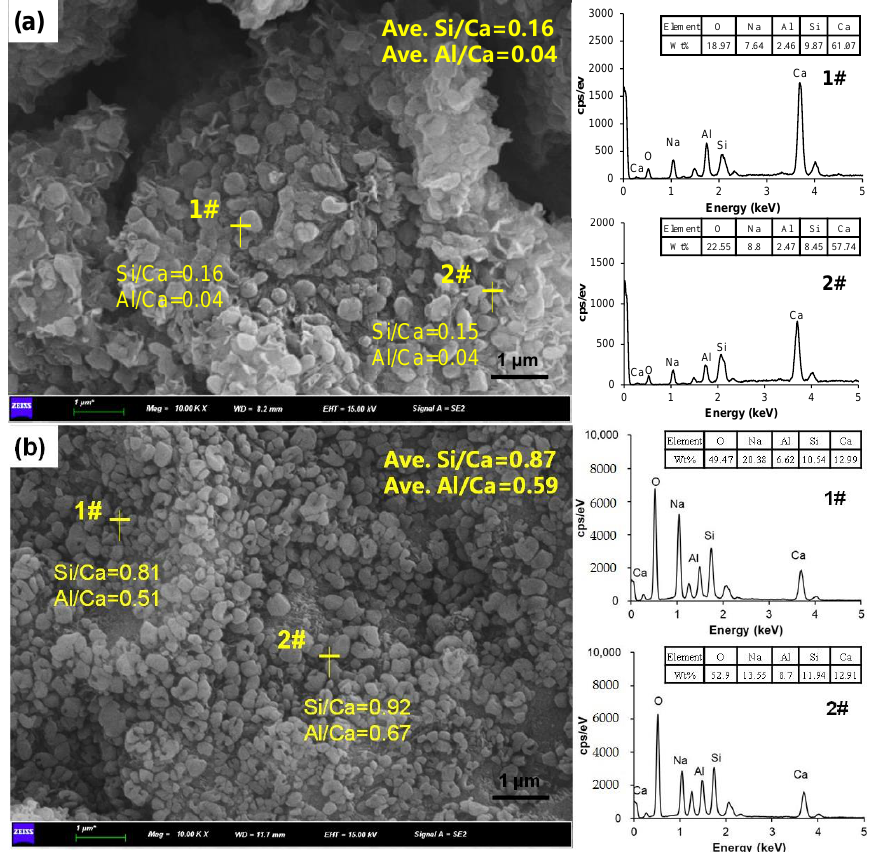
Figure 11. SEM-EDS results of 56-day-aged binder pastes prepared with ( a ) 0% MK and ( b ) 15%